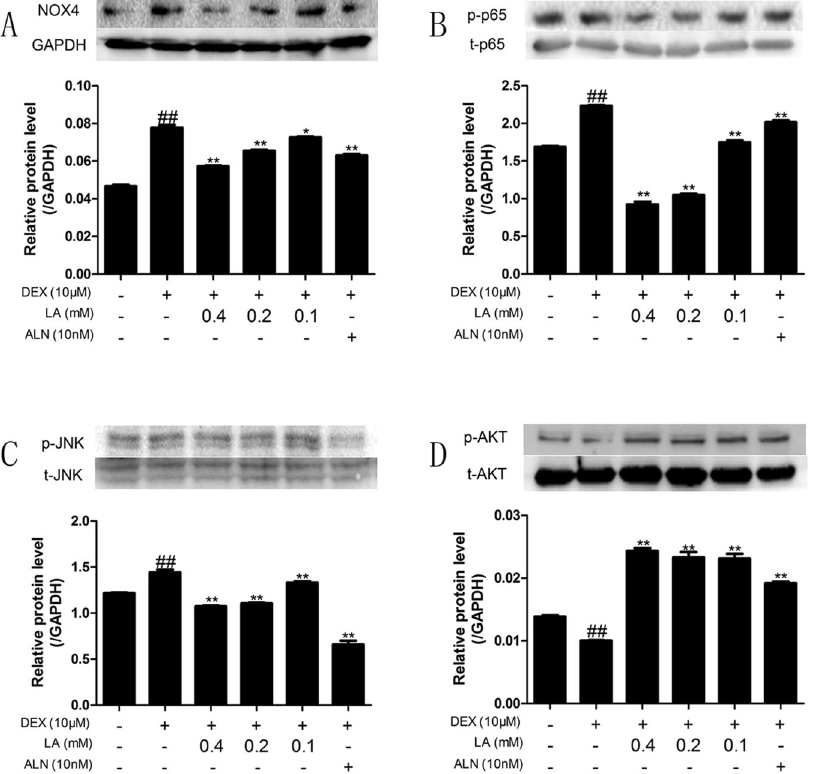
Figure 9. The expression levels of NOX4, NF-kappaB, JNK and the PI3K/AKT signalling pathway in MC3T3-E1 cells. NOX4 ( A ) and levels of phosphorylation of p65 ( B ) and levels of phosphorylation of JNK ( C ) and levels of phosphorylation of AKT ( D ) were detected by western blotting. GAPDH was used as loading control. Data were expressed as mean ± SD of three independent experiments. # p < 0.05 and ## p < 0.01 compared with the control group. * p < 0.05 and ** p < 0.01 compared with the DEX-alone